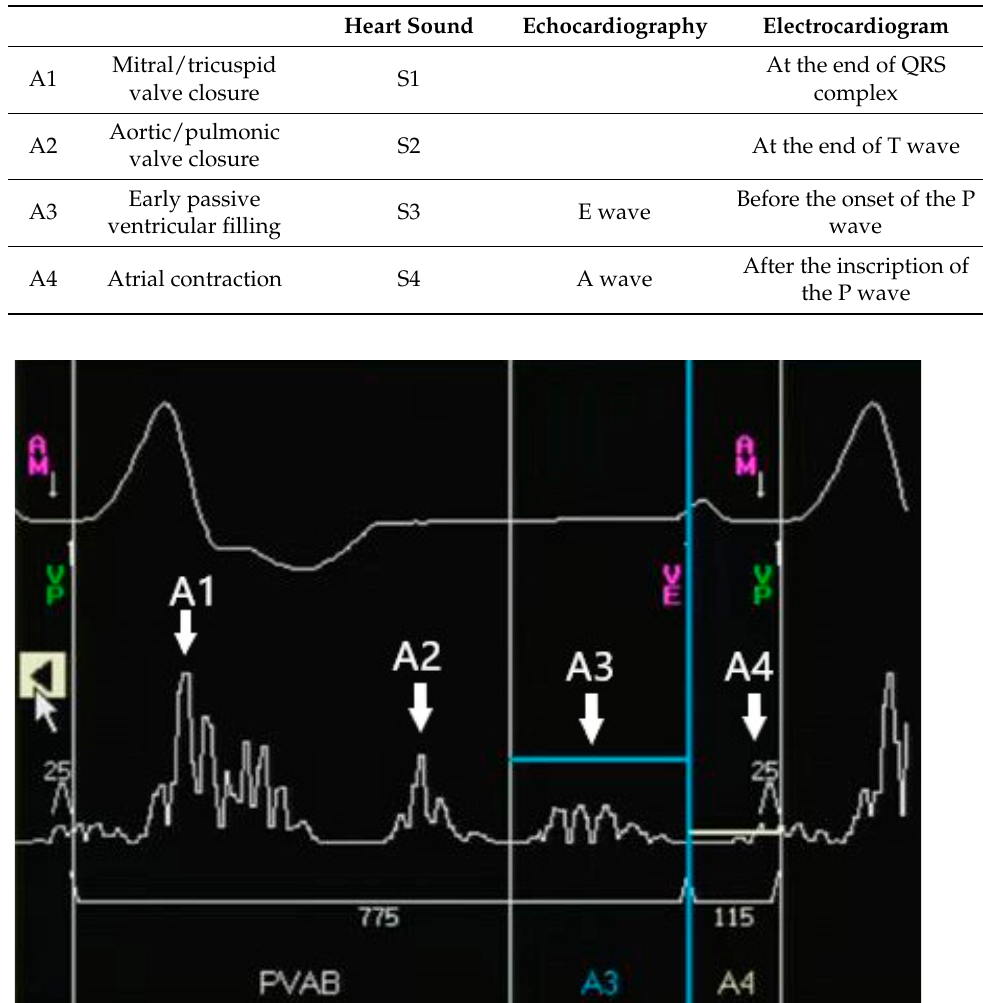
Figure 2. Schematic illustration and explanation of the key atrial sensing parameters. The top signal shows the electrocardiogram; the bottom signal shows the accelerometer signal. shows the electrocardiogram; the bottom signal shows the accelerometer